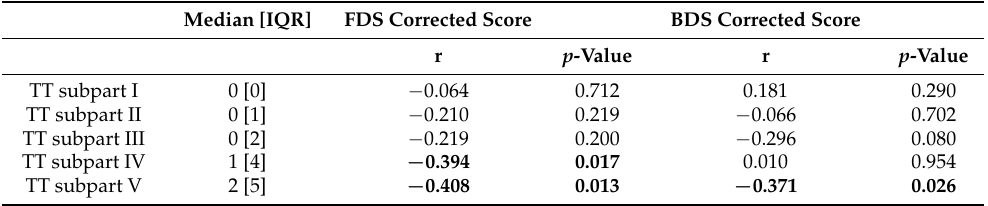
Table 3. Partial correlation analyses between Token Test errors and corrected digit span forward and backward scores, adjusted by